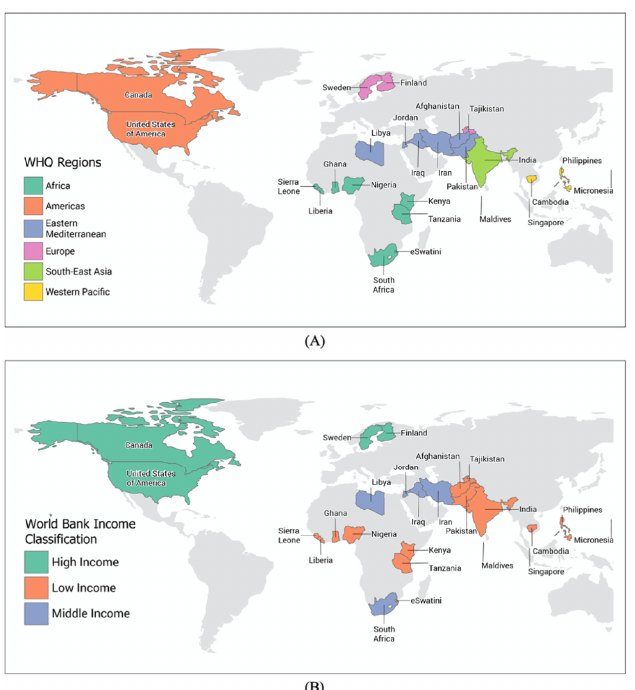
Figure 1. ( A ) Overview of the NAP case studies by global region. ( B ) Overview of the NAP case studies by income classification. studies by income